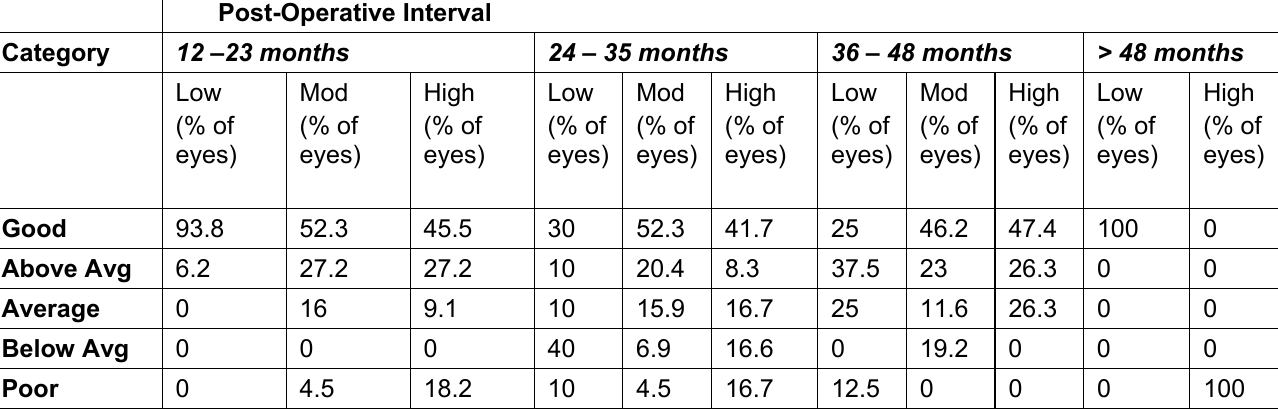
Table 4 .Categorization of glare recovery times for the different degrees of pre-operative refractive errors in the different post-operative